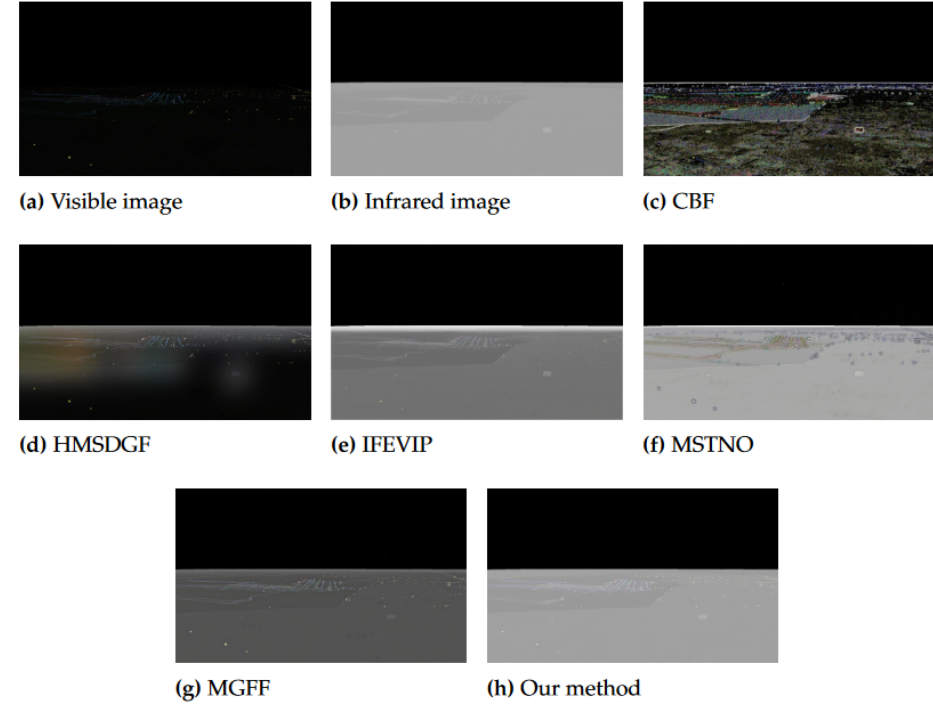
Figure 26. Visual comparison between different fusion methods of Image2.